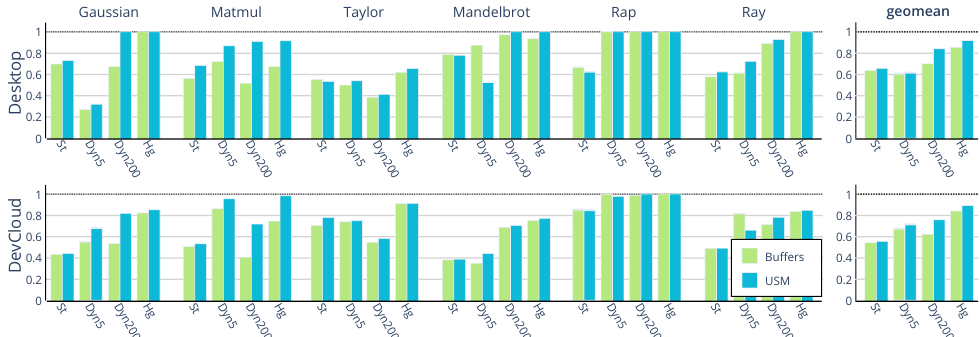
Figure 7. Efficiency for a set of benchmarks when doing CPU-GPU co-execution in Desktop and DevCloud